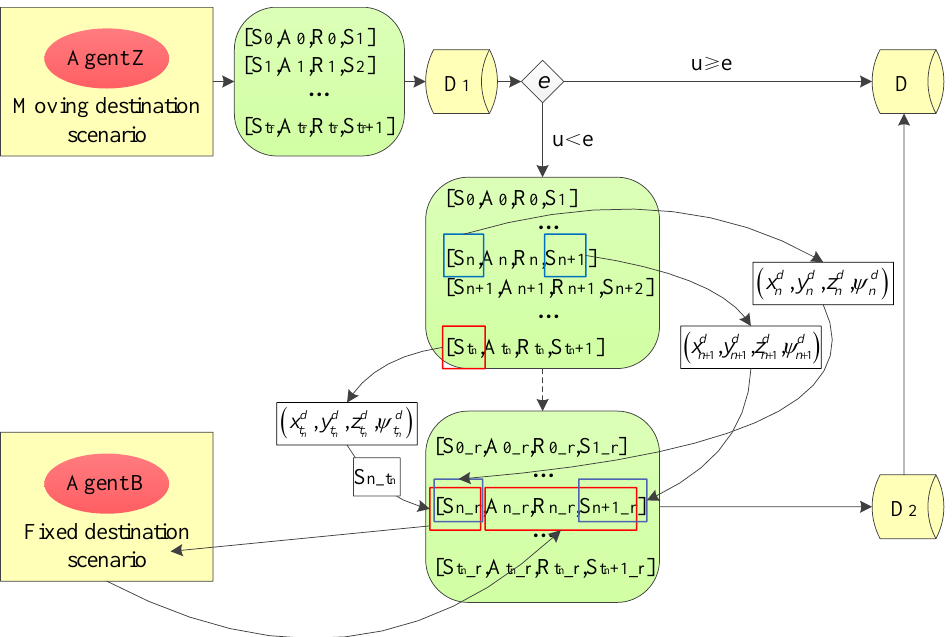
Figure 4. Illustration of policy-reuse algorithm based on destination position prediction. The policy-reuse algorithm based on destination position prediction is shown in Algorithm 1. In the new guidance task, the input interface of agent Z includes aircraft position, destination position and the last action, and the output interface outputs one of the seven discrete actions, which are the same as those of agent B . At each time step t , the data generated in an episode using agent Z is stored in tuples. A random number u in [0, 1] is generated and compared with the current agent selection factor e . If u is greater than or equal to e , tuples are not updated; otherwise, agent B is used to update tuples. As shown in Figure 3, the aircraft has the possibility of reaching the destination at any step from 1 to t f , so a loop from 1 to t f is operated to search for a possible termination step t n . For each step t n in the loop, the destination position in each tuple from t 0 to t n is replaced with the destination position in S t in step t n , and it is saved as S n _ t . The purpose n n of this process is to change the tuple into the tuple in the fixed-position destination scenario by replacing the destination position in the state so as to meet the use conditions of baseline ] is generated using agent B . With state S n _ t as input, a new tuple [ S n _ t , A n _ r , R n _ r , S n + 1_ t n n n baseline agent B . In this tuple, A n _ r is the action performed by the aircraft, and R n _ r is the evaluation of this action, which can be used to train agent Z . However, the destination positions in S n _ t and S n + 1_ t are not the positions in the actual scenario, which need n n further transformation. Since the destination positions in S n and S n + 1 are generated by destination movement, a new tuple [ S n _ r , A n _ r , R n _ r , S n + 1_ r ] is saved by replacing the destination positions in S n _ t and S n + 1_ t with destination positions in S n and S n + 1 . In this n n tuple, the action is generated by the baseline agent B , and the destination position in the state is the actual trajectory of the destination in the moving-destination scenario. At any time in the loop, the update of tuples finishes when the aircraft successfully arrives at the destination. Finally, the DRL algorithm is used to train agent Z with the saved tuples. The agent selection factor e needs to be updated. When it is less than or equal to 0, the algorithm stops updating and makes it equal to